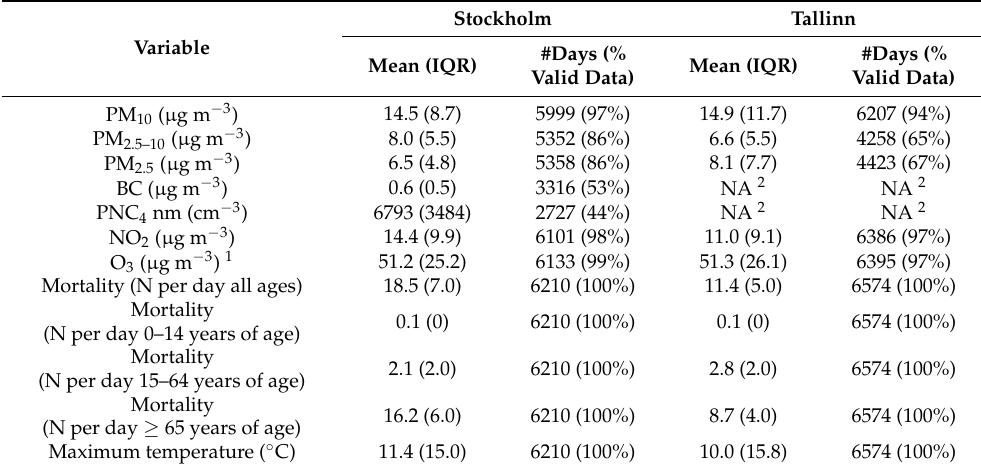
Table 2. Summary statistics of the daily data from 2000 to 2016 in Stockholm and from 2001 to 2018 in